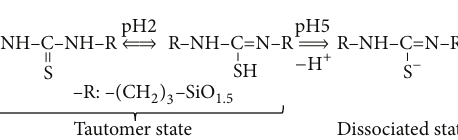
Figure 5: FT-IR spectrum of PSTM-3T polymer after treatment by pH = 5 (a) and pH = 2 (b) acidic solutions.